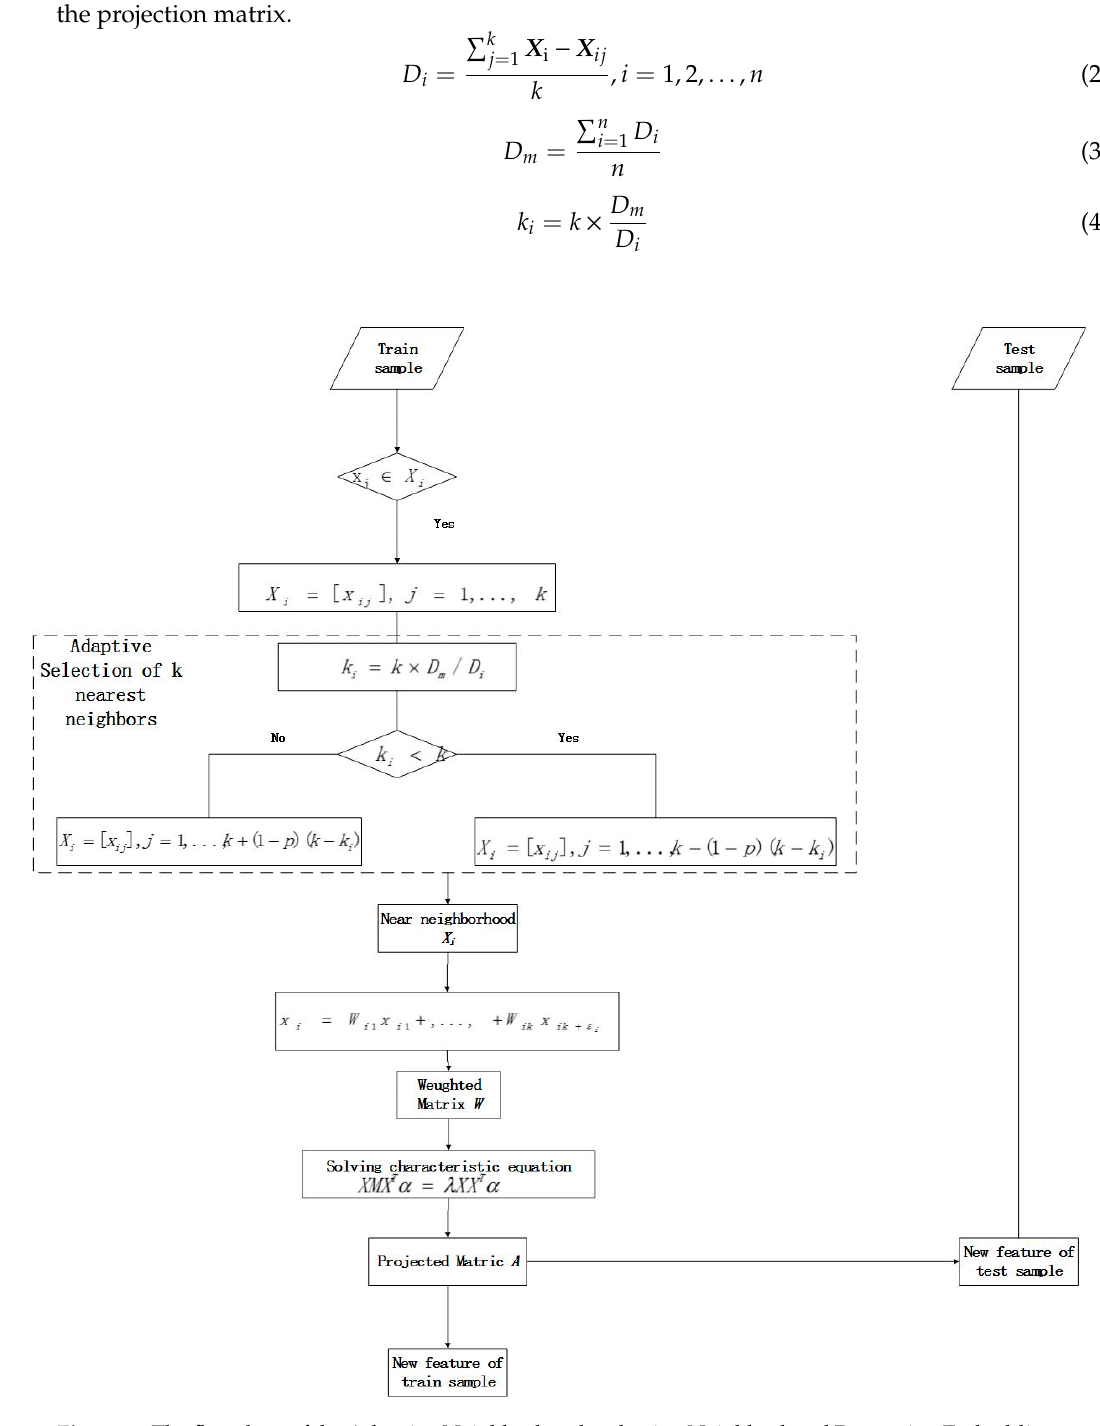
Figure 1. The flowchart of the Adaptive Neighborhoods selection Neighborhood Preserving Embedding (ANSNPE) algorithm.